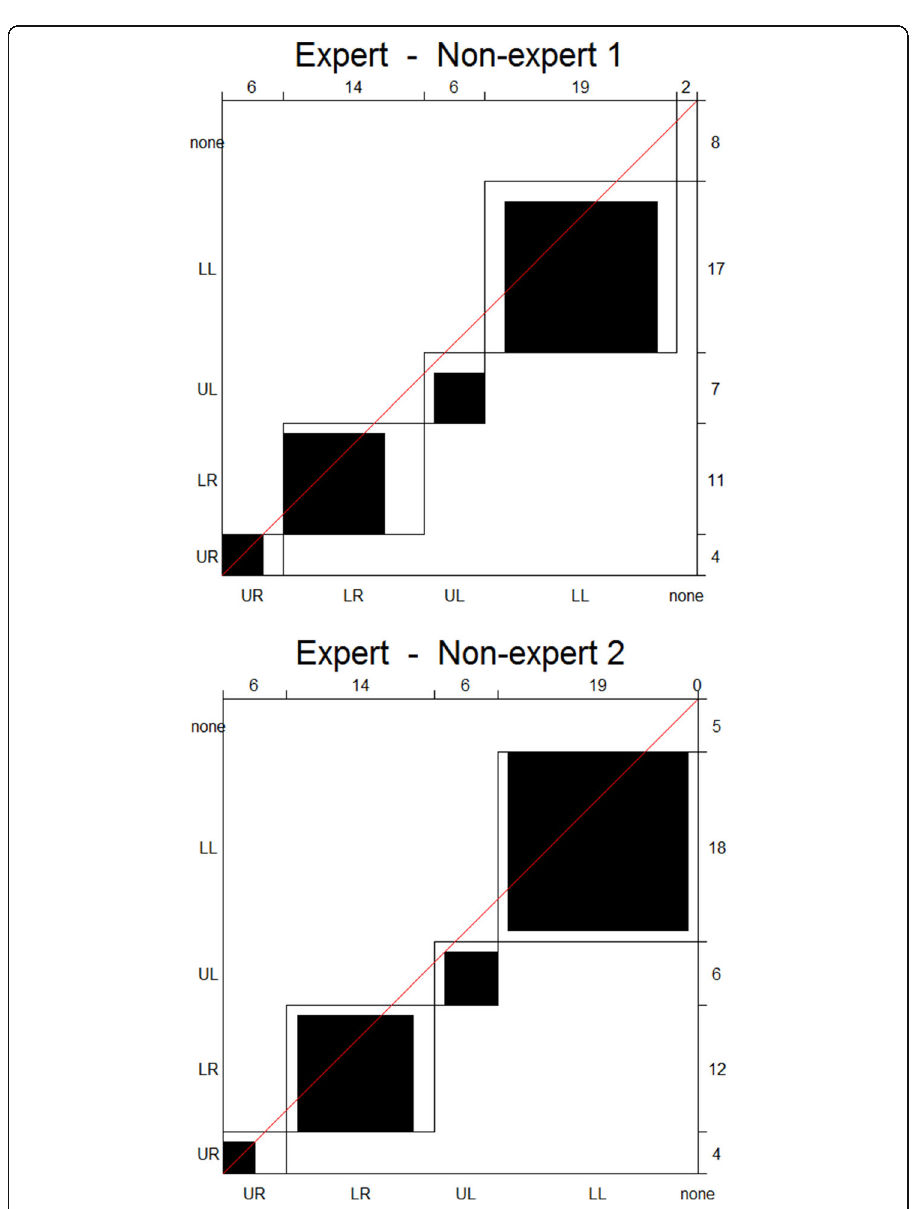
Fig. 3 Agreement plots for inter-observer agreement on anatomical location. From the expert reader compared to the two non-experts individually. Left, non-expert 1; right, non-expert 2. The expert is marked on the x-axis and the non-expert on the y-axis. UR, upper right; LR, lower right; UL, upper left; LL, lower left. Due to the high number of none-none agreements, these have been omitted for the agreement plots, but can be seen in the supplementary